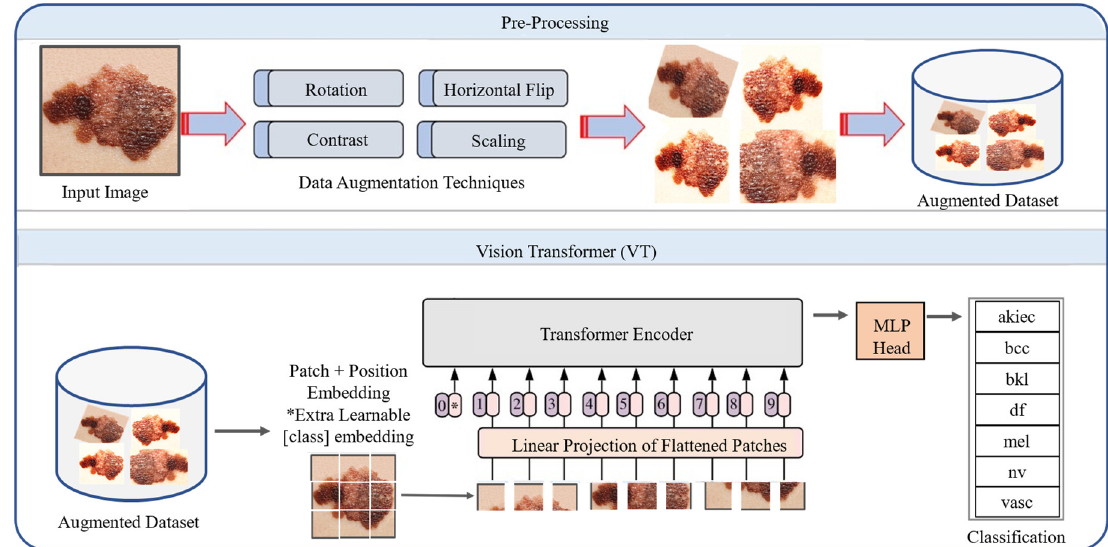
Figure 2. Proposed MVT-based SC classification framework .